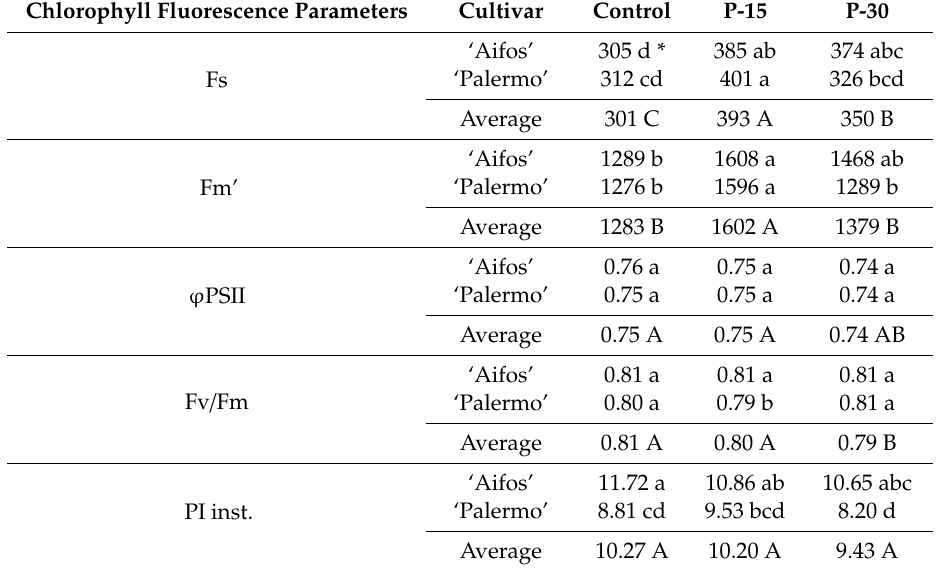
Table 2. E ff ect of fertilizer with polyphosphates in hydroponic cultivation on the photosynthetic activity of pepper leaves depending on the cultivar (average of two